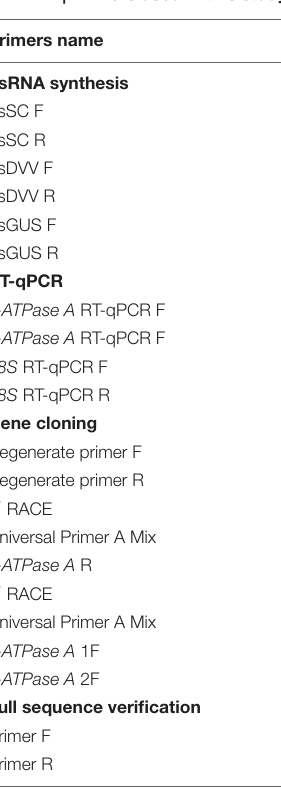
TABLE 1 | Primers used in this